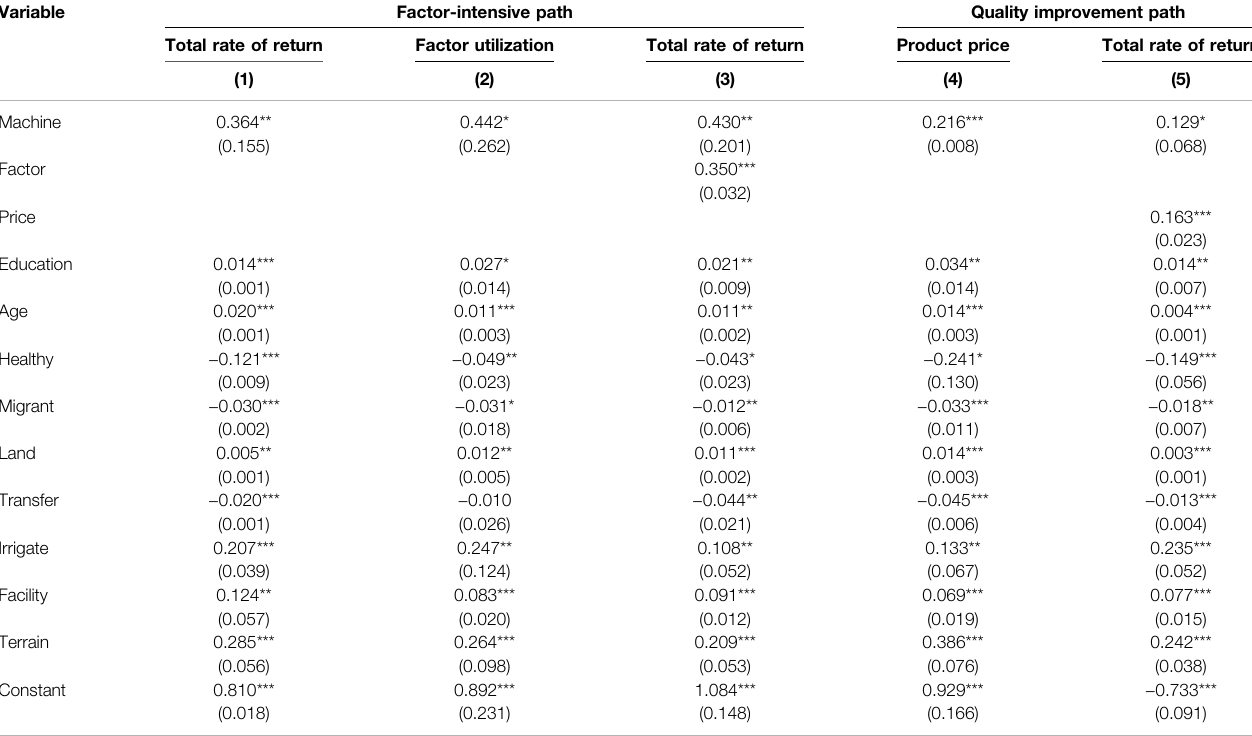
TABLE 9 | Mechanism of the effect of agricultural mechanization level on pro fi t.